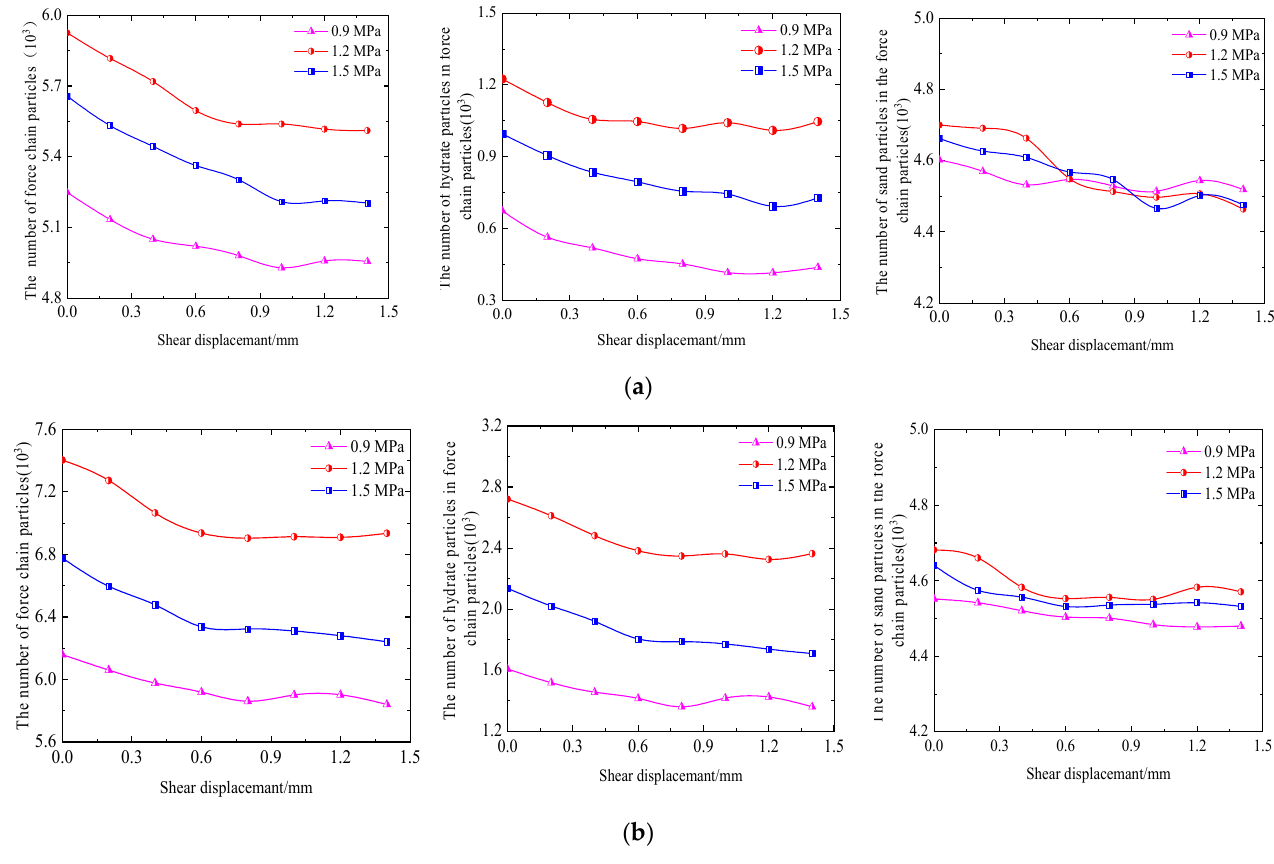
Figure 17. In direct shear test, the number of high stress particles of natural gas hydrate deposits under different conditions: ( a ) S h = 20%, ( b ) S h = 30%.